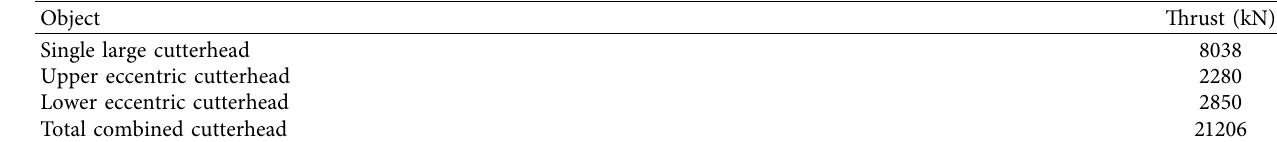
Table 5: Calculated thrust for each cutterhead.